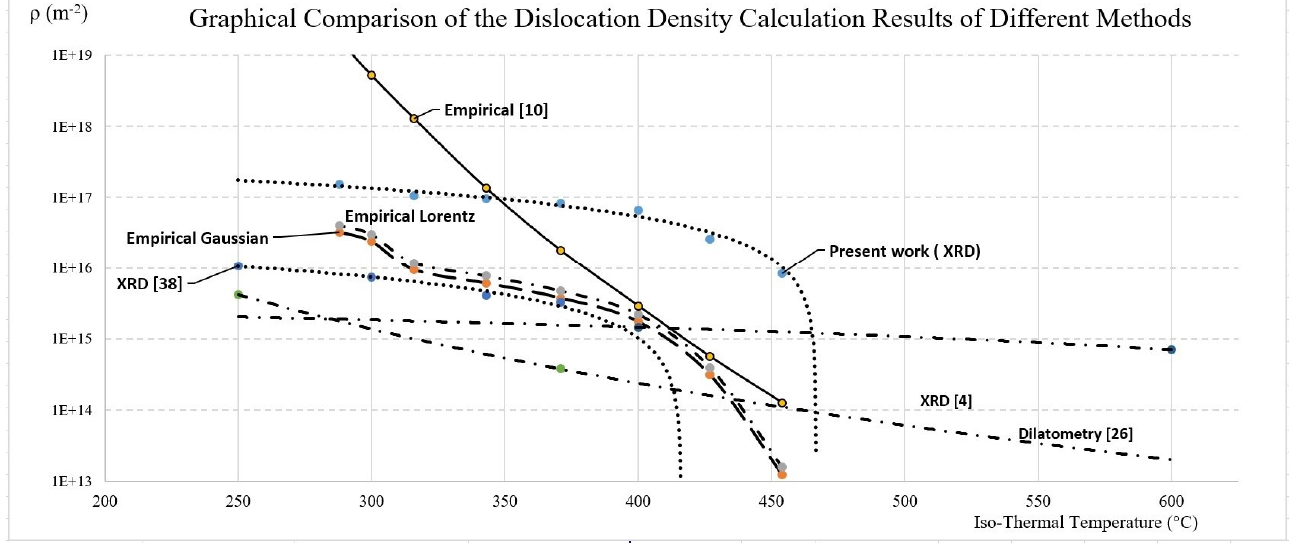
Figure 4. Isothermal temperature effect on dislocation density and hardness.